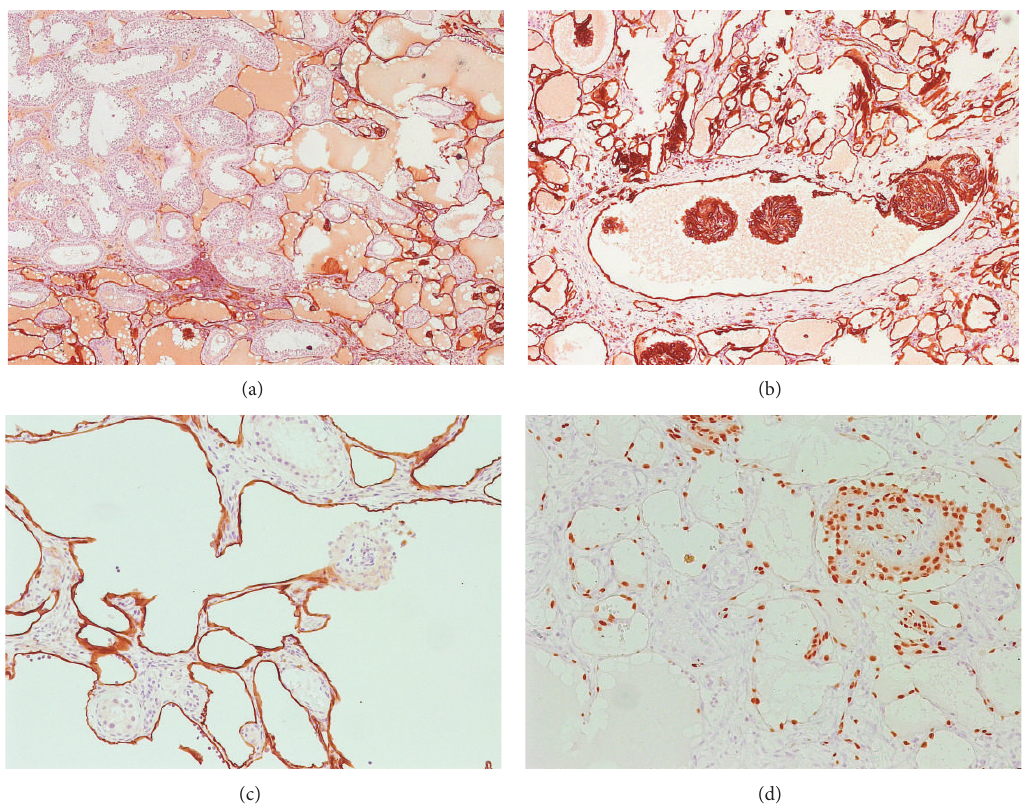
Figure 2: Immunohistochemistry. (a) CD-31 2.5x; (b) CD-31 20x; (c) D2-40 20x; (d) ERG 40x. Images show strong nuclear positivity for ERG in the vessel lining cells, as well as the papillary